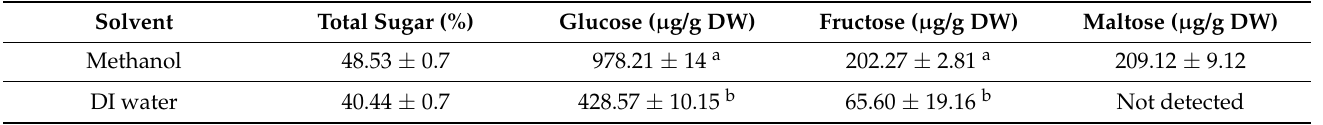
Table 1. Total sugar content (%), glucose, fructose, and maltose in the fruit of A. garckeana in methanol